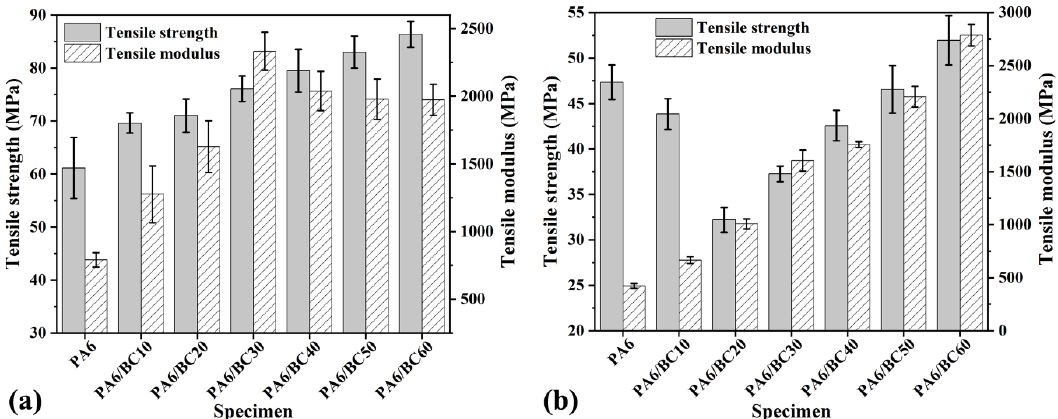
Figure 4. Tensile properties of PA6/BC composites with different BC contents, ( a ) no water treatment, ( b ) water treatment.